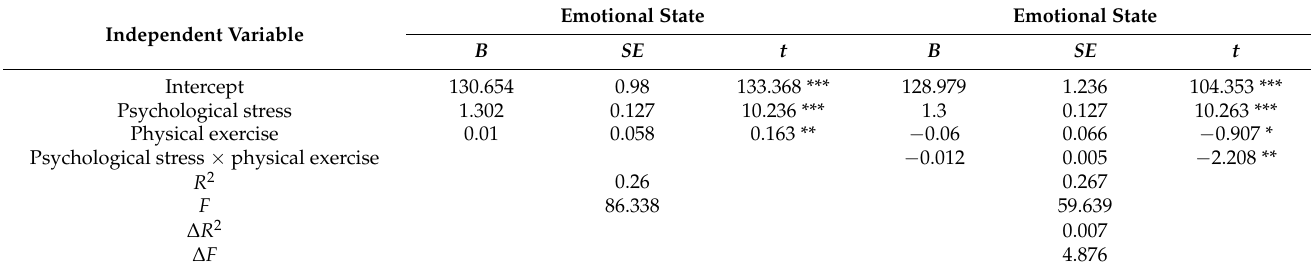
Table 3. Moderation effect analysis.